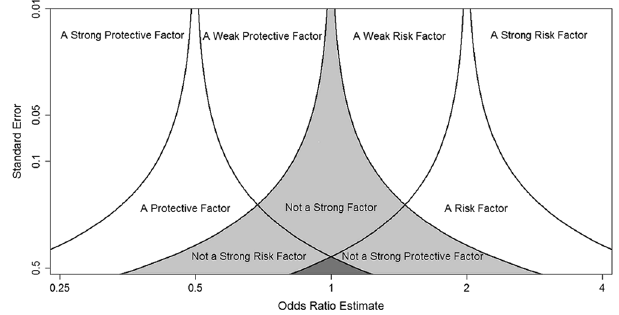
Figure 1. The nine possible conclusions of the five-region test (a strong protective factor: the upper left non- shaded corner; a weak protective factor: the middle left non-shaded area; a protective factor without strength information: the non-shaded area nestled between the upper left non-shaded corner and the middle left non- shaded area; a weak risk factor: the middle right non-shaded area; a strong risk factor: the upper right non- shaded corner; a risk factor without strength information: the non-shaded area nestled between the middle right non-shaded area and the upper right non-shaded corner; not a strong risk factor: the left lightly-shaded area; not a strong protective factor: the right lightly-shaded area; not a strong factor, risk or protective: the middle lightly-shaded